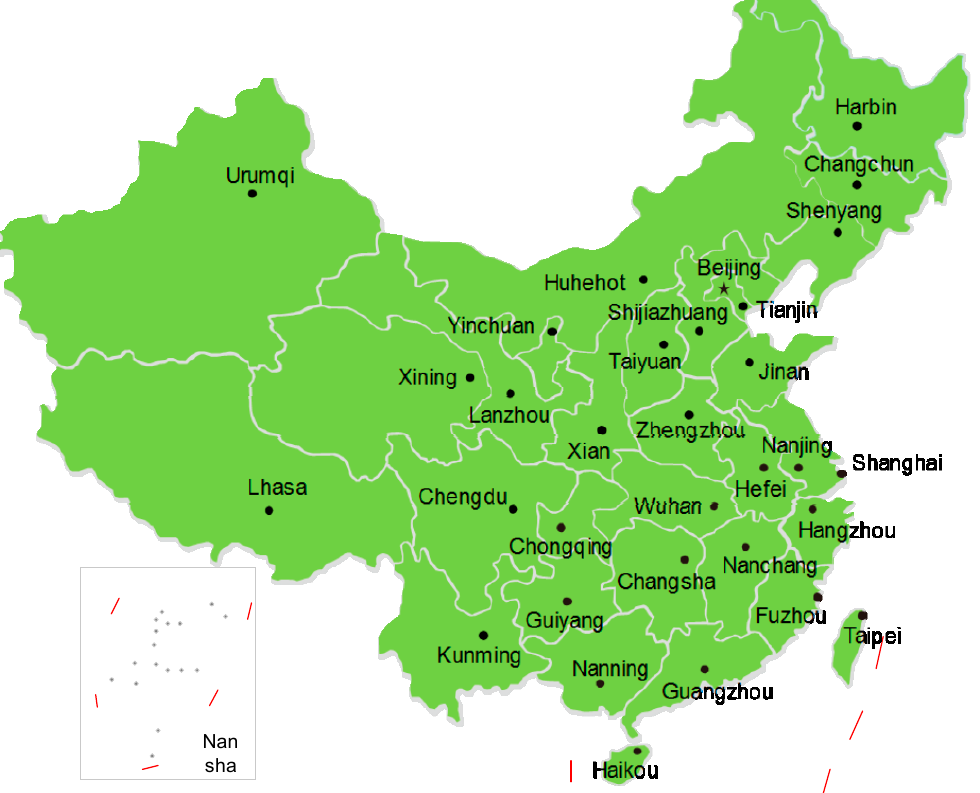
Figure 1. The thirty-one sample cities. (Source: the map is drawn by smart-draw software according to China’s National Administrative Planning Map [61]).